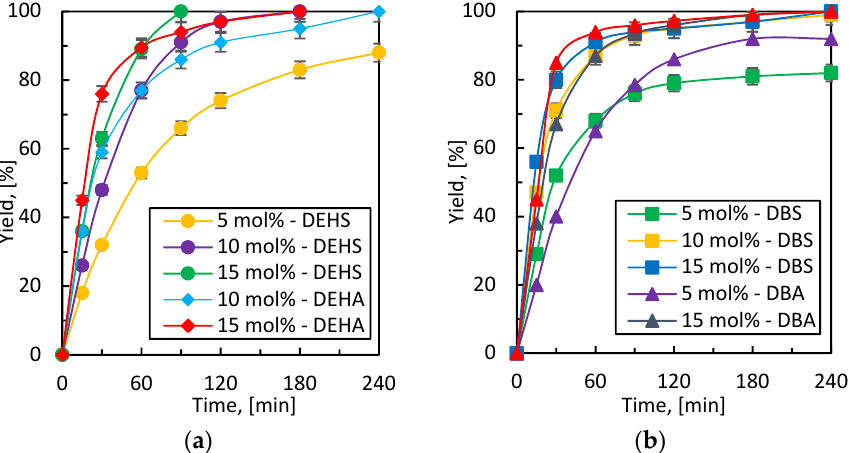
Figure 2. The influence of the amount of IL 2.7 on the on the esterification of succinic and adipic acid with ( a ) butan-1-ol and ( b ) 2-ethylhexan-1-ol. Reaction conditions: alcohol 4 mol; acid 1 mol; 70 °C (DBS, DEHS); 80 °C (DBA, DEHA); 17 Hz.